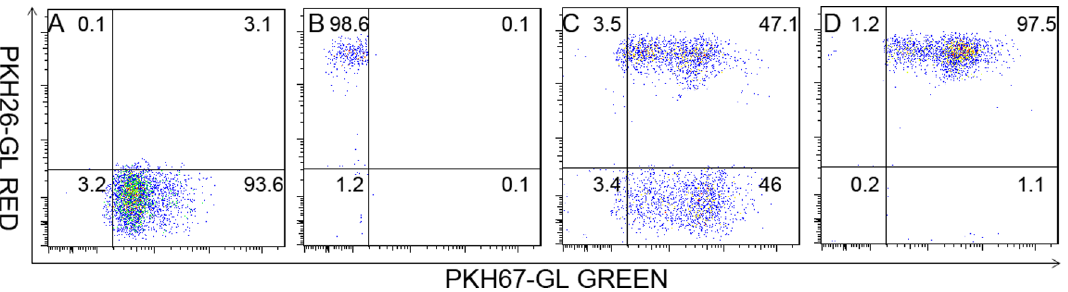
Figure 1. FACS analysis of electro-fusion between auto DCs and tumor cells. Prior to fusion, DCs and tumor cells were stained red and green (from patient 4), respectively, using the PKH26-GL and PKH67-GL kits. Tumor cells were then irradiated with 5000 cGy, and standard electro- fusion was performed on the DCs and tumor cells at a ratio of 2:1. The fusion mixture was incubated overnight in a CO 2 tissue culture incubator. On the second day, cells were collected and subjected to FACS analysis. The red DCs and green tumor cells were clearly distinct(A, B). The amount of double-positive hybrid cells in adherent cell population was 47% (C), and 97% in the purified hybrids cell population (D).